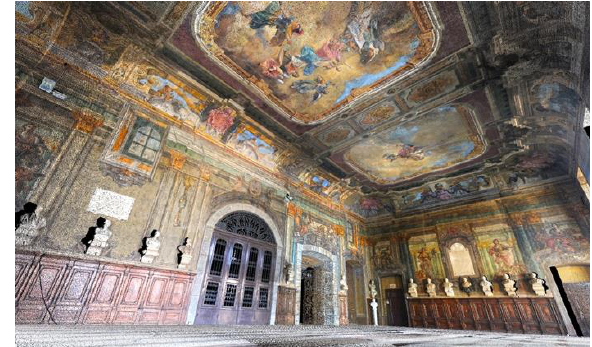
Figure 8. The complex point cloud of the Hall of